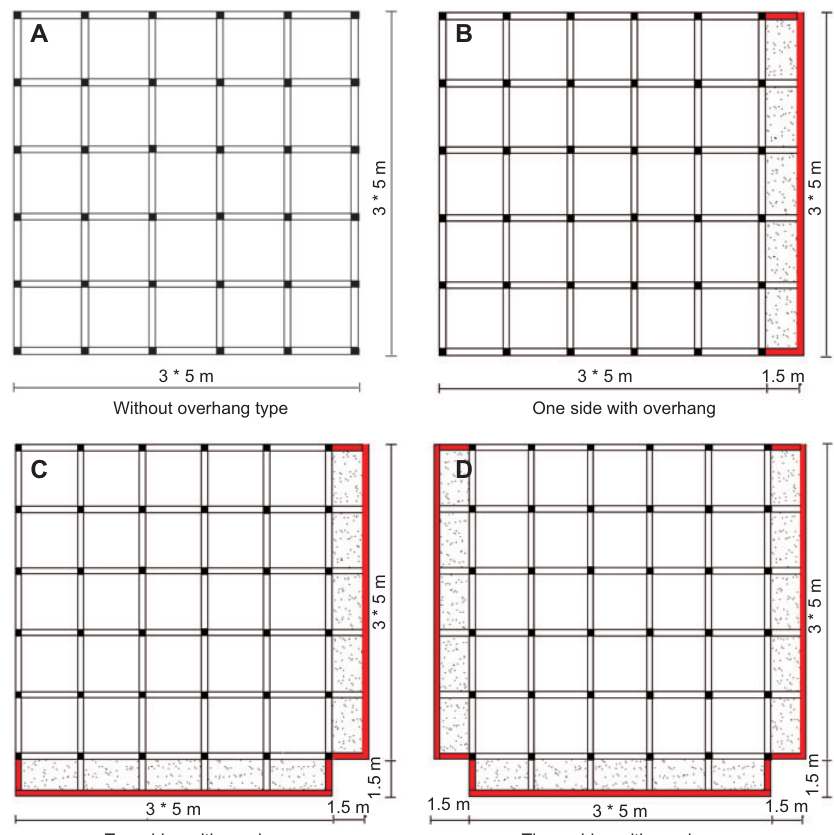
Figure 3 Selection of model type. method. The structure of feed-forward multilayer